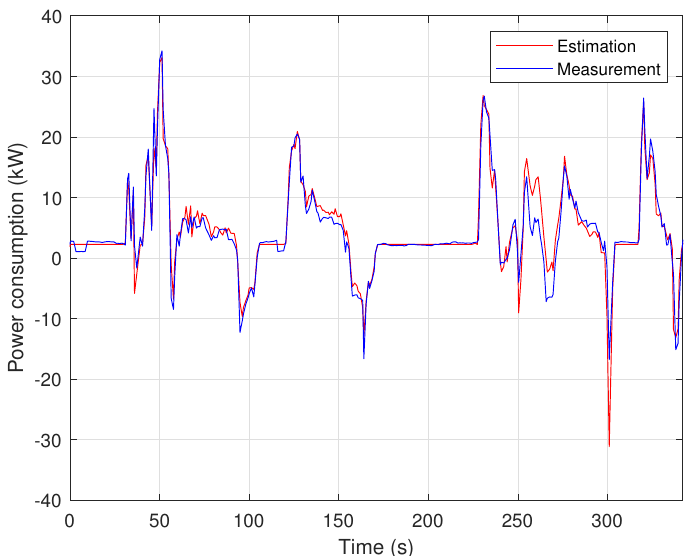
Figure 2. Theoretical prediction and real-world measurement of energy